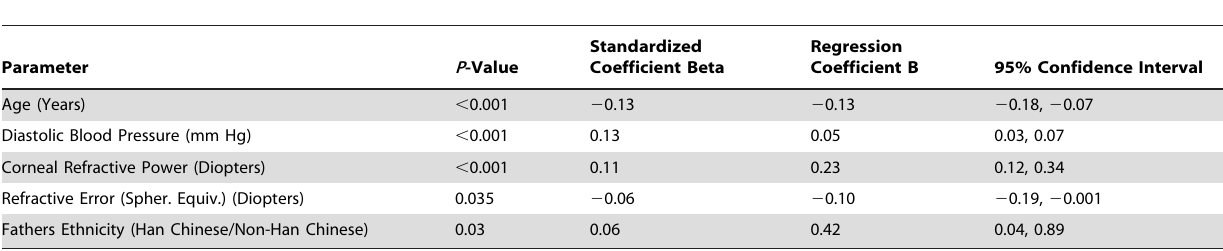
Table 3. Associations (Multivariate Analysis) between Intraocular Pressure (Right Eyes) and Systemic and Ocular Parameters in the Gobi Desert Children Eye